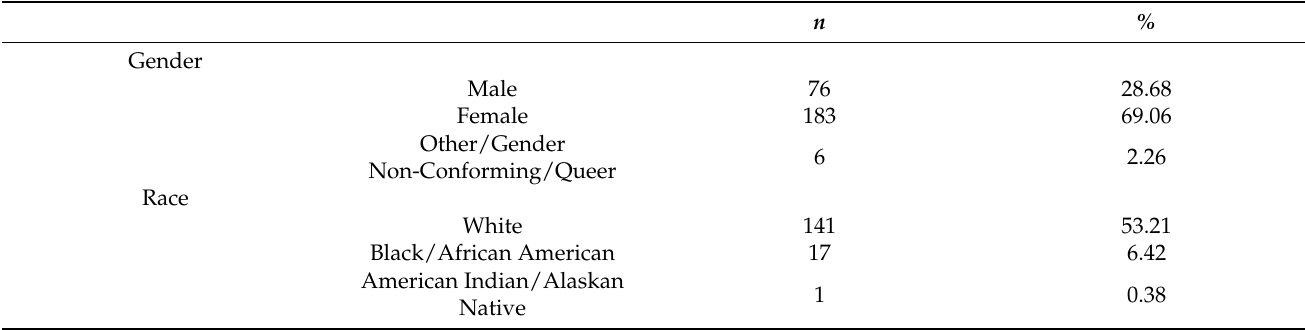
Table 1. Demographic Characteristics ( N =